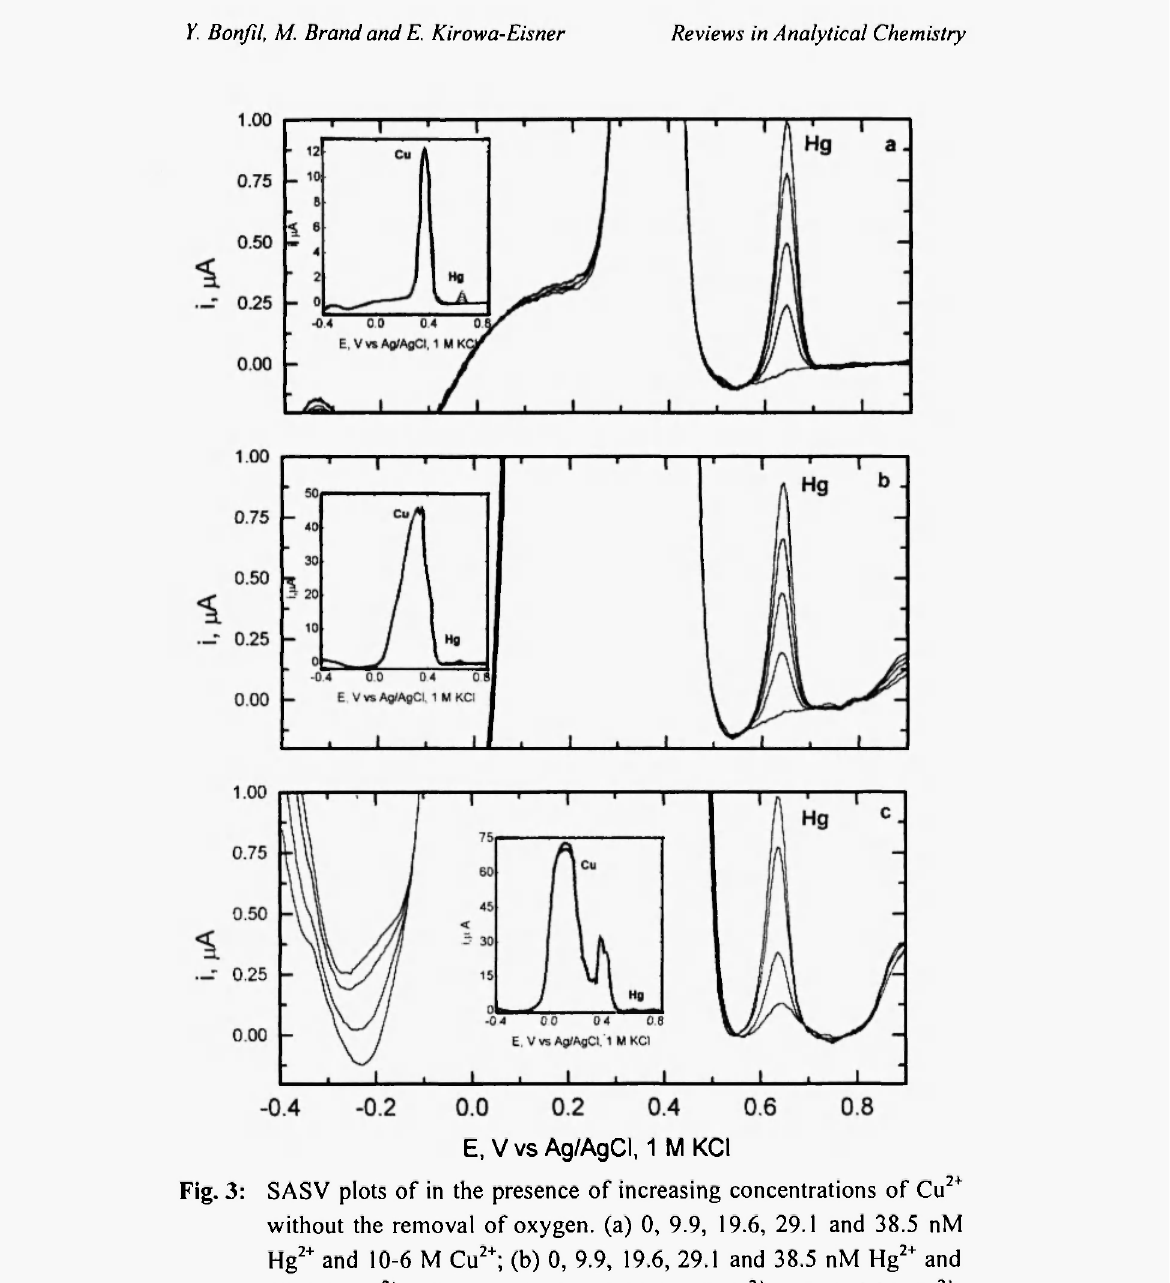
Fig. 3: SASV plots of in the presence of increasing concentrations of Cu 2+ without the removal of oxygen, (a) 0, 9.9, 19.6, 29.1 and 38.5 nM Hg 2+ and 10-6 Μ Cu 2+ ; (b) 0, 9.9, 19.6, 29.1 and 38.5 nM Hg 2+ and 10-5 Μ Cu 2+ ; (c) 0, 9.9, 29.1 and 38.5 nM Hg 2+ and 10-4 Μ Cu 2+ . Edep = -·4 V; t dep = 30 s; all other conditions as in Fig. 1. The plots are presented in two sensitivities: in the main figure the sensitivity is high in order to observe the mercury peaks and in the inserts the sensitivity is low in order to observe the entire